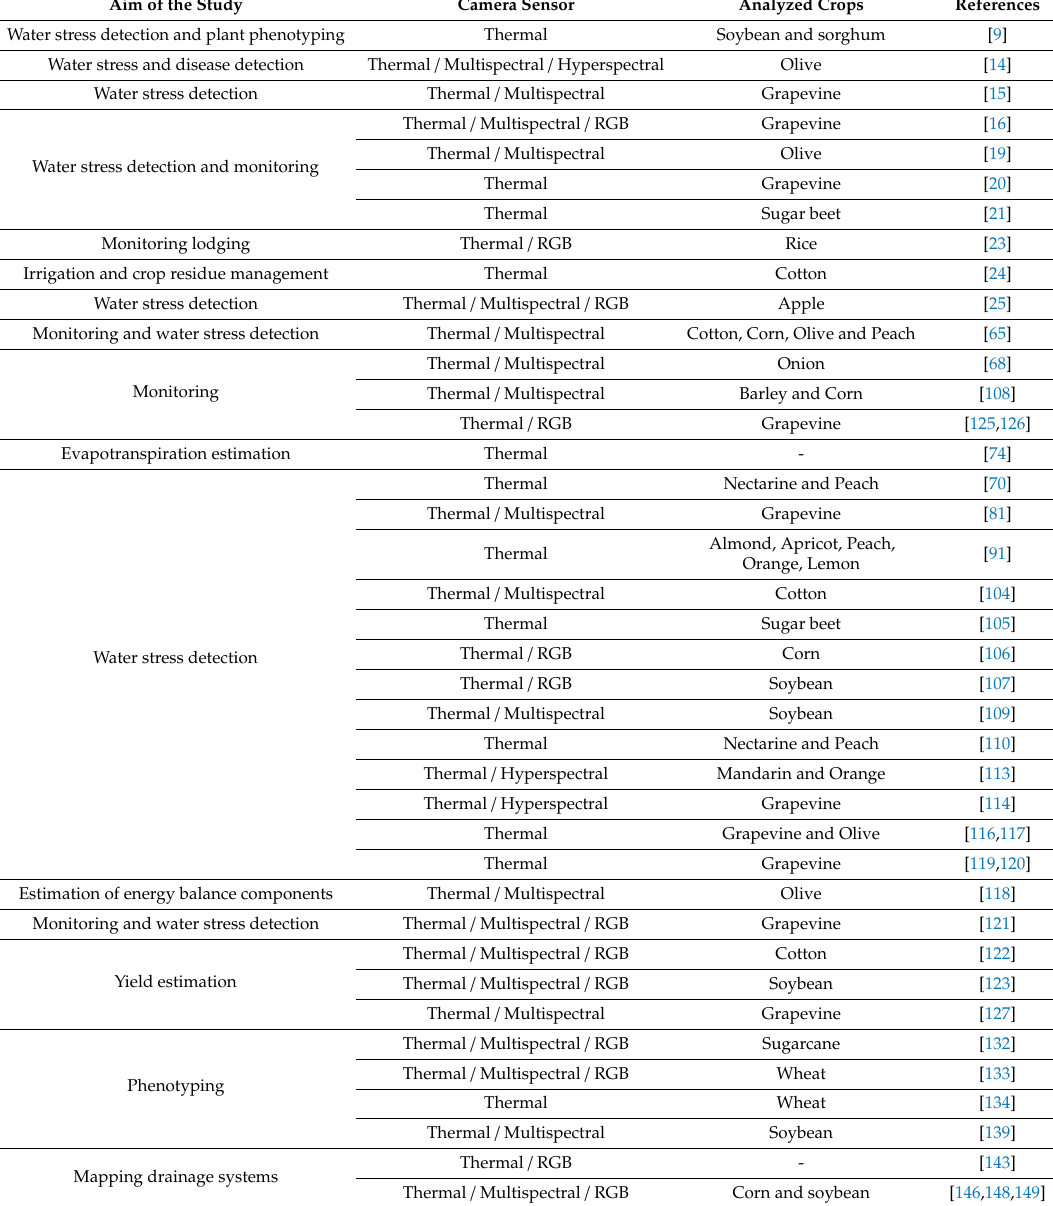
Table 2. Dataset compilation of studies concerning the application of thermal UAV remote sensing (RS) in precision agriculture